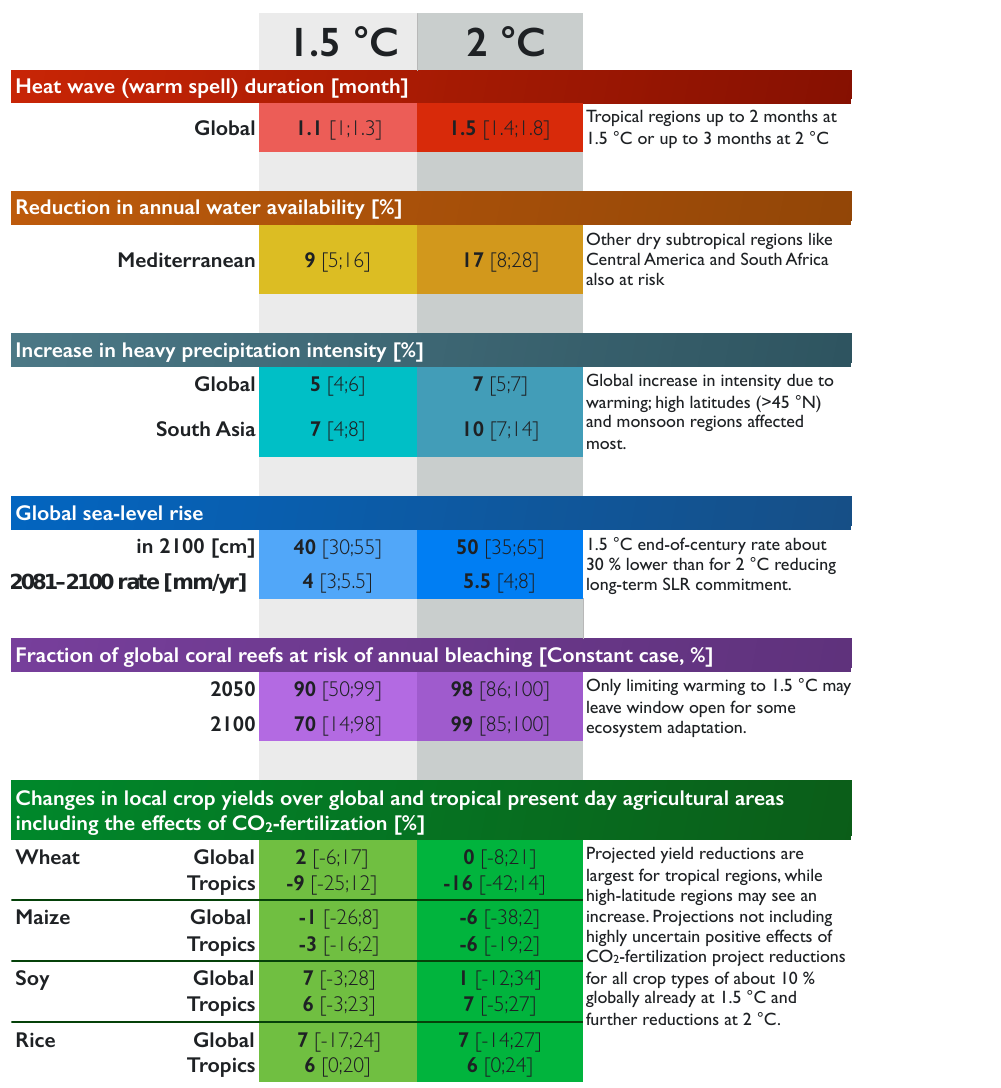
Figure 15. Summary of key differences in climate impacts between a warming of 1.5 ◦ C and 2 ◦ C above pre-industrial and stylized 1.5 ◦ C and 2 ◦ C scenarios over the 21st century. Square brackets give the likely (66%)